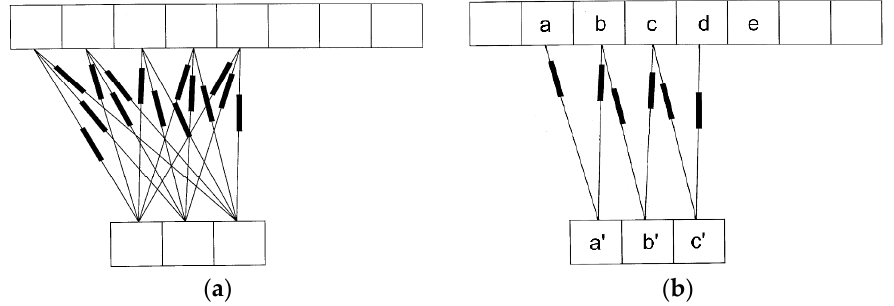
Figure 2. Example of the auxiliary network used for taking into account the presence of sliding contacts. ( a ) All the branches are shown. ( b ) Only the branches that are not open circuits are evidenced.